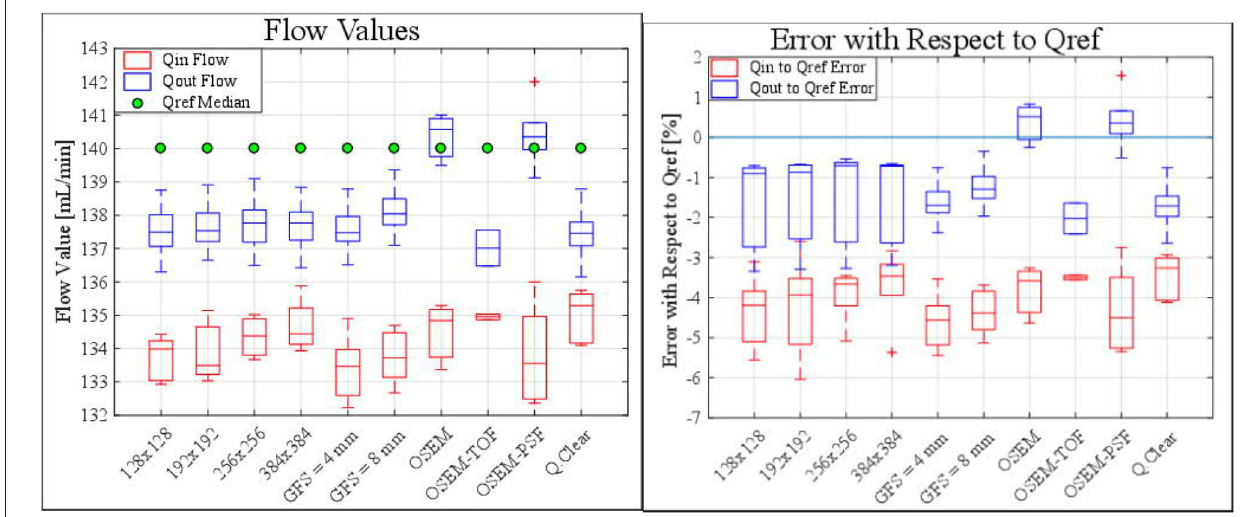
FIGURE 4 | Boxplots show the distribution and median of Qin and Qout (A) flow values and (B) errors with respect to Qref (reference flow) for all the subsequent reconstructions over all the measurements. The median value for the reference flow Qref for all reconstructions was measured as 140